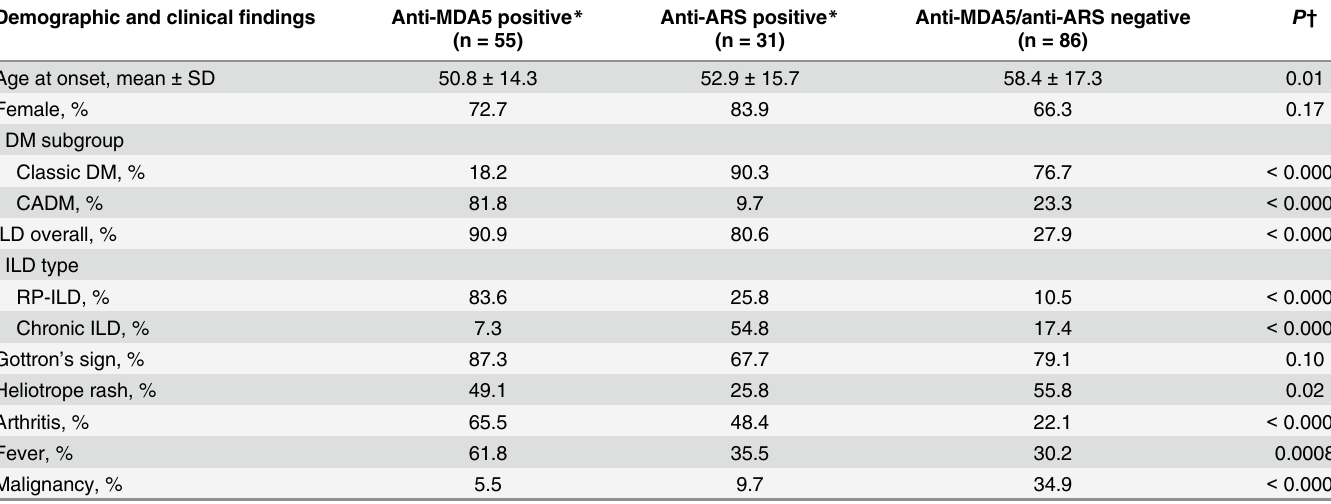
Table 2. Clinical characteristics of patients with DM, stratified by autoantibody status. Demographic and clinical fi